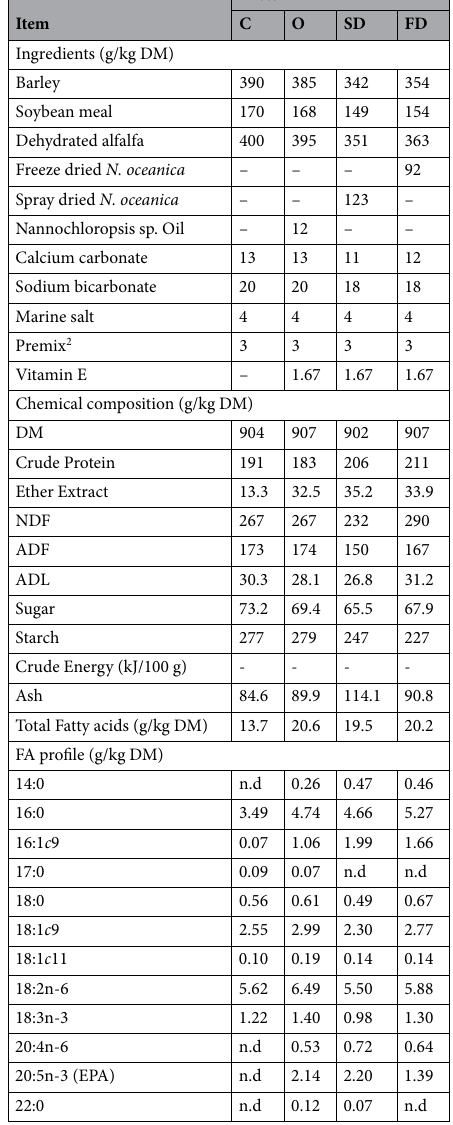
Table 4. Ingredients, chemical composition, and fatty acid profile of the experimental diets. 1 Diets (or treatments): C, control; O, Control plus 1.2% Nannochloropsis sp. oil; SD, control plus 12.3% spray-dried Nannochloropsis oceanica ; FD, control plus 9.2% freeze-dried N. oceanica . 2 Premix composition: Vitamin